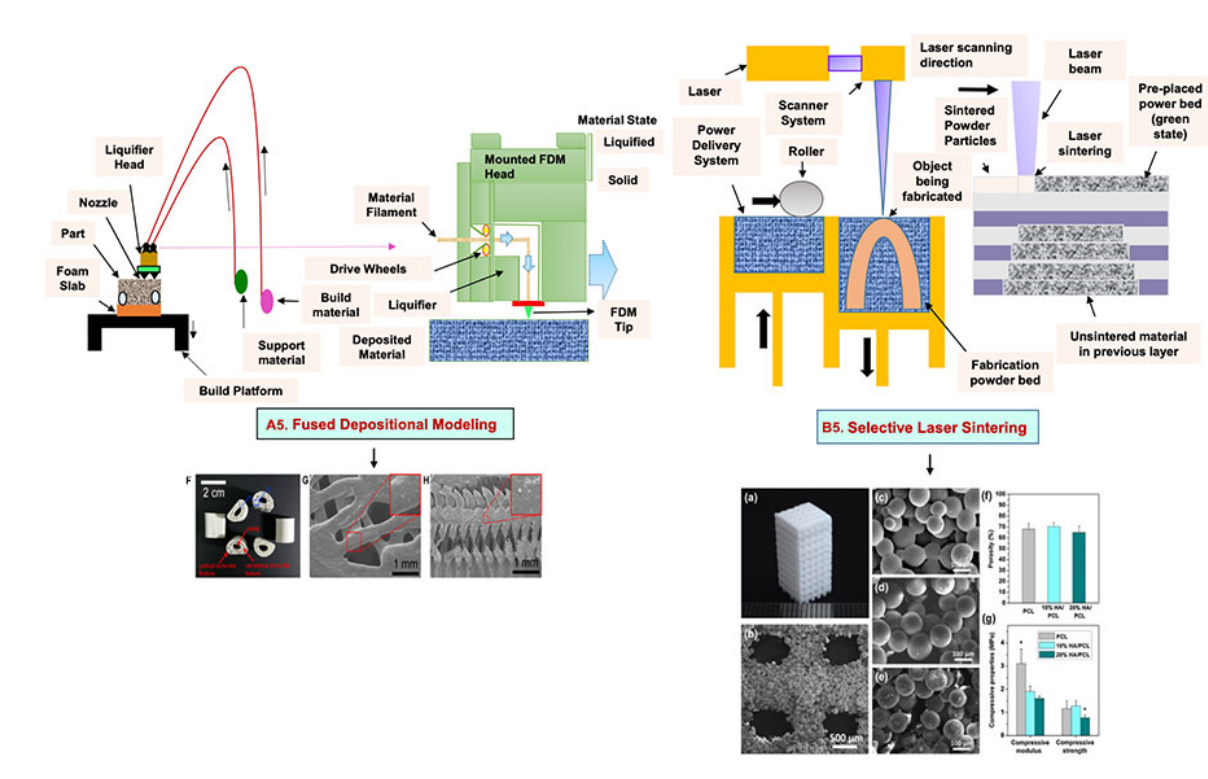
Figure 5. Schematic illustration of ( A5 ) FDM. Reprinted with permission from Ref. [53]. Copyright 2020, Elsevier Ltd.; ( F ) The developed PCL/HA 3D artificial bones. ( G ) Surface view of PCL/HA 3D artificial bone, in which upper-right image is magnified. ( H ) Cross-sectional view of PCL/HA 3D artificial bones, in which the upper-right image is magnified from the corresponding area. Reprinted with permission from Ref. [114]. Copyright 2014, ACS Publications and ( B5 ) SLS (adapted from [53]); ( a ) The developed sintered scaffold of cuboid-shaped morphology and highly ordered porous structure. ( b ) SEM image showed the detailed morphology of pores in a representative 10% HA/PCL scaffold. ( c – e ) SEM micrographs verified the microspheres were well connected via laser sintering in PCL scaffolds ( c ), 10% HA/PCL ( d ) and 20% HA/PCL ( e ). ( f ) The porosity analysis ( g ) mechanical properties of the scaffolds. All data represented the mean ± SD; n = 5, * p < 0.05 (data compared with other two groups). Reprinted with permission from Ref. [115]. Copyright 2015, Elsevier Ltd.